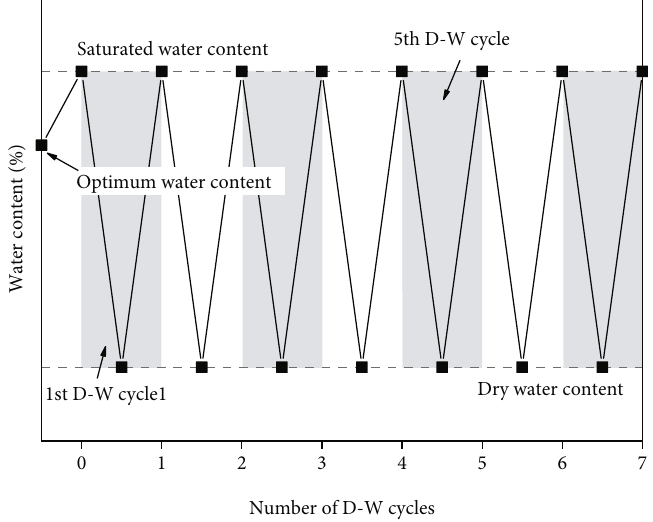
Figure 5: D-W cycle paths of soil